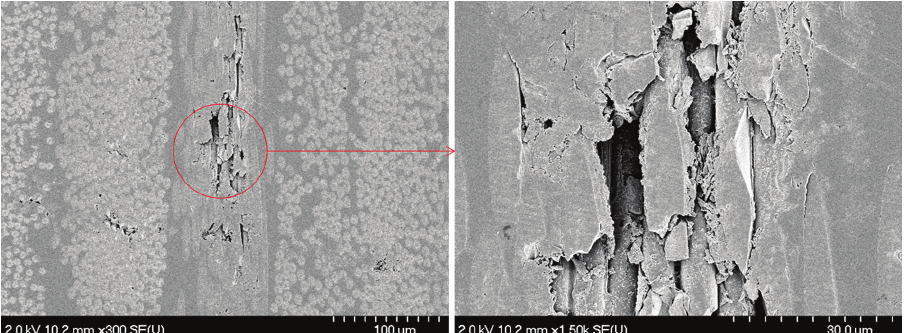
Figure 16: Presence of large defects in non-autoclave-treated sample taken from truncated cone # 1.